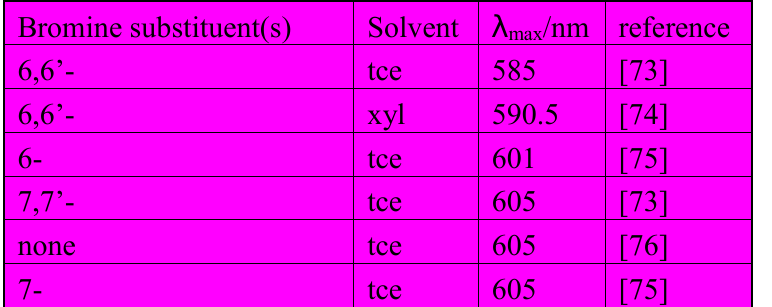
) of various brominated indigo max